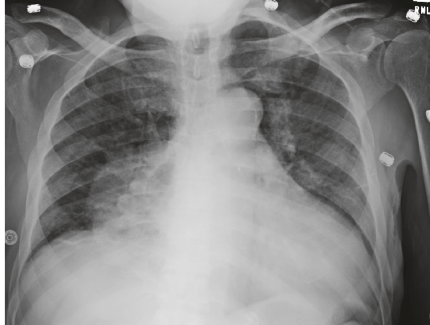
Figure 2: Chest X-ray showing a pneumopericardium, most prob- ably due to the direct extension of the fungal infection (day